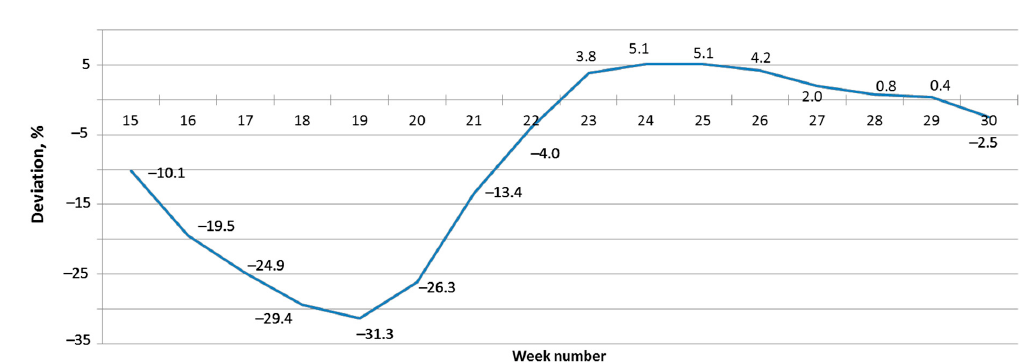
Figure 8. Deviation of the weekly forecasted maximum NDVI values from the actual maximum, % (Khabarovsk District, 2019).